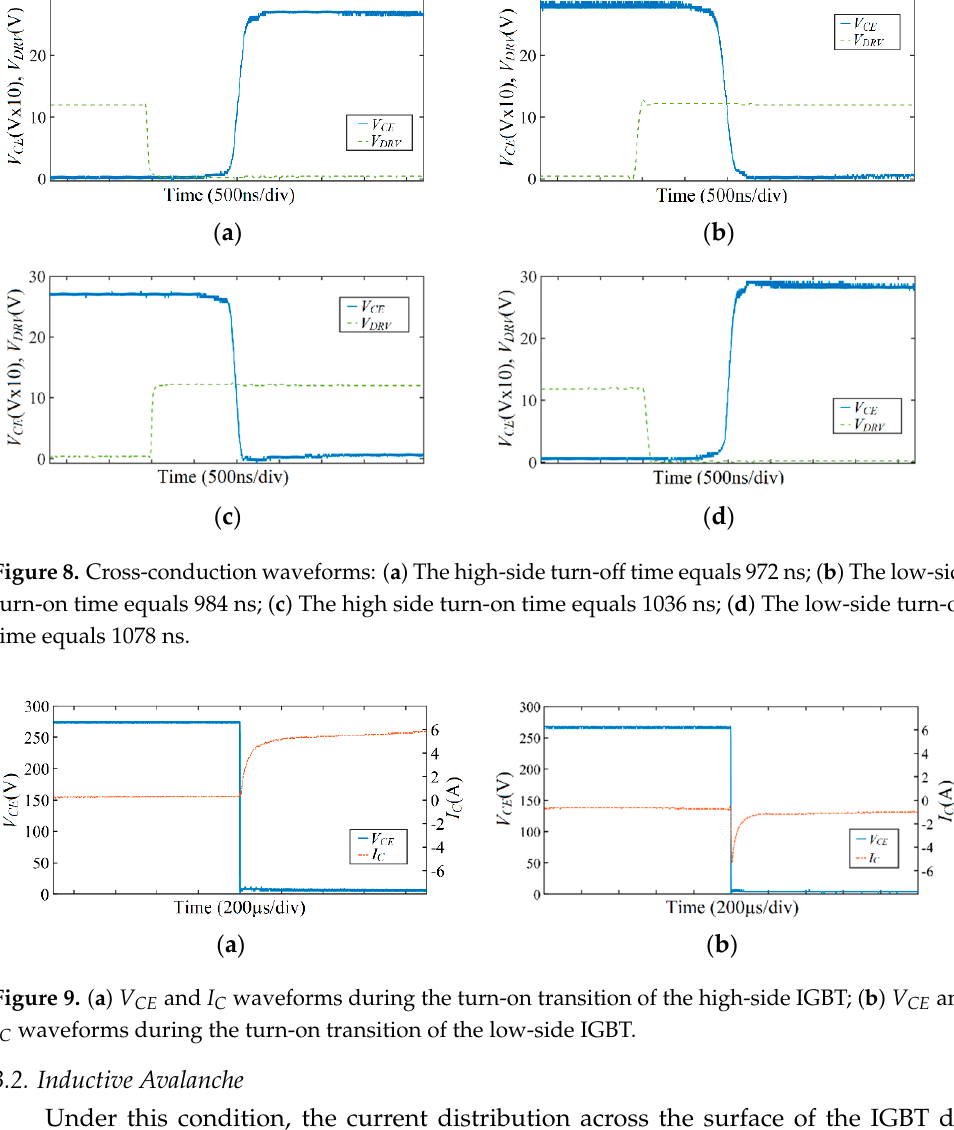
Figure 9. ( a ) V CE and I C waveforms during the turn-on transition of the high-side IGBT; ( b ) V CE and I C waveforms during the turn-on transition of the low-side IGBT.